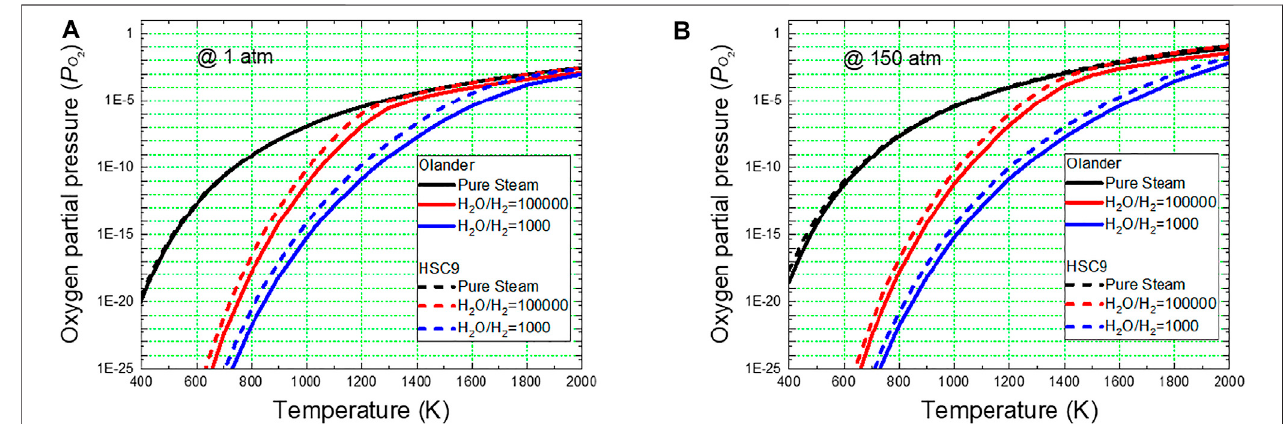
FIGURE 1| Comparison of equilibrium oxygen partial pressures ofsteam and steam – hydrogen mixed gases as afunction oftemperature for total pressures of (A) 1 atm and (B) 150 atm, calculated through the HSC9 program (HSC Chemistry 9, 2018) and Olander ’ s equation (Olander, 1986).